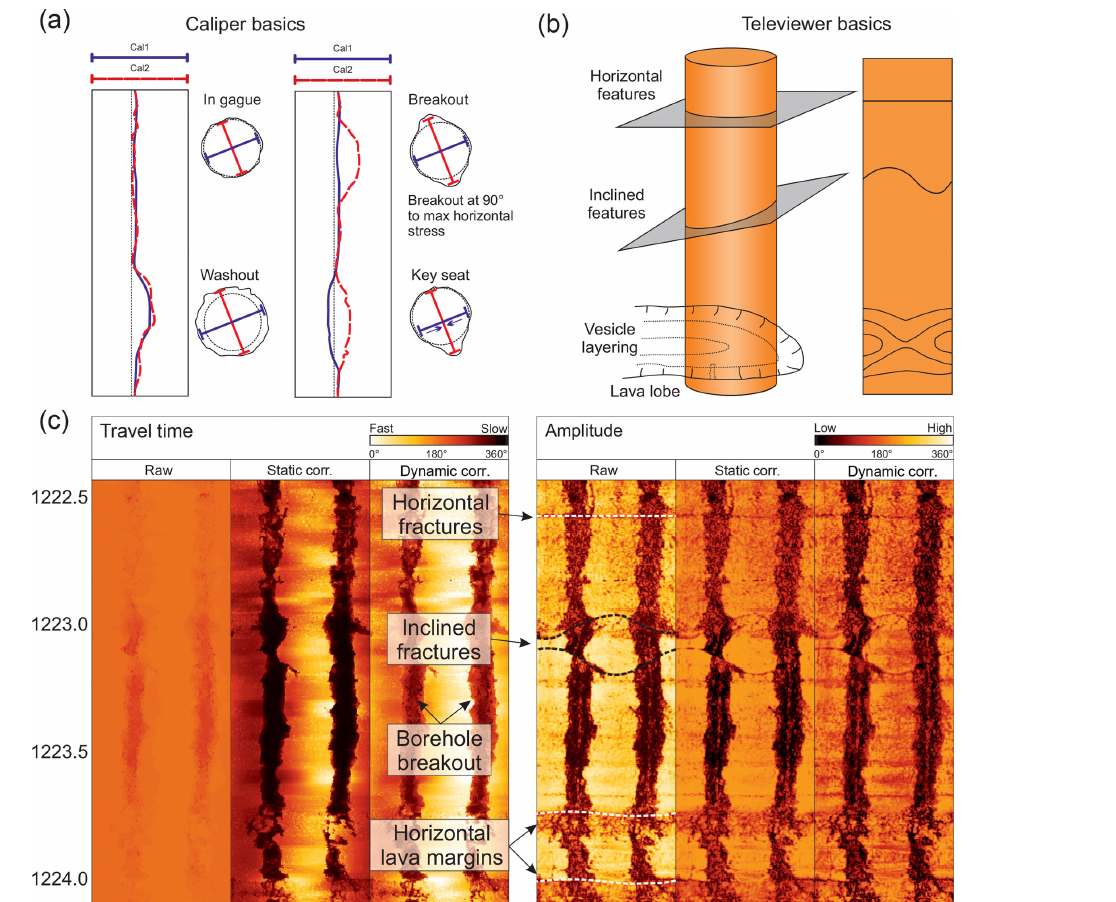
Figure 5. (a) Simplified schematic displaying the four-arm caliper response to common borehole conditions (following Reinecker et al., 2003). (b) Basics of televiewer imaging of borehole features. (c) Example of some of these features from the PTA2 borehole televiewer